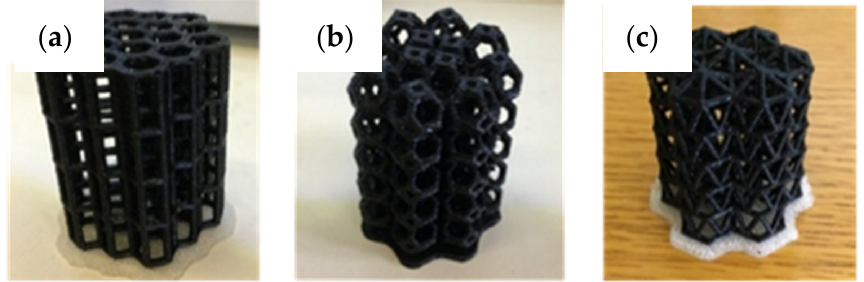
Figure 4. Renderings of CAD models: ( a ) hexagonal with rectangular cell; ( b ) truncated octahedron; ( c ) icosahedron.